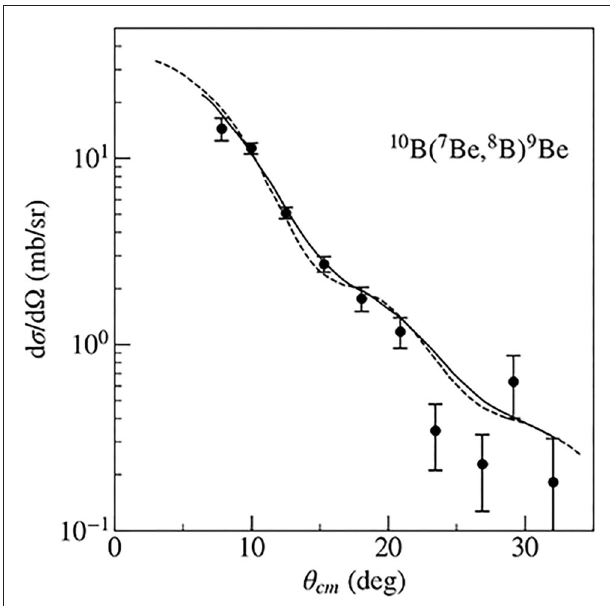
FIGURE 6 | Experimental angular distribution from the 10 B( 7 Be, 8 B) 9 Be reaction for the outgoing ions 7 Be. The dashed line corresponds to the predicted angular distribution and the solid line is corrected to finite angular distribution (Azhari et al.,